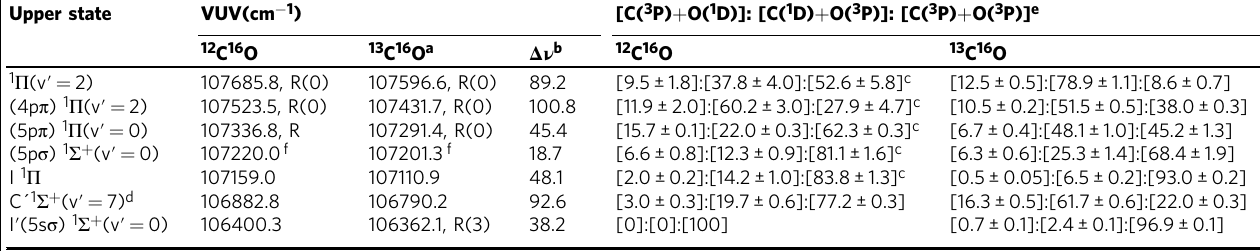
Table 1 Measured photodissociation branching ratios of 12 C 16 O and 13 C 16 O Upper state